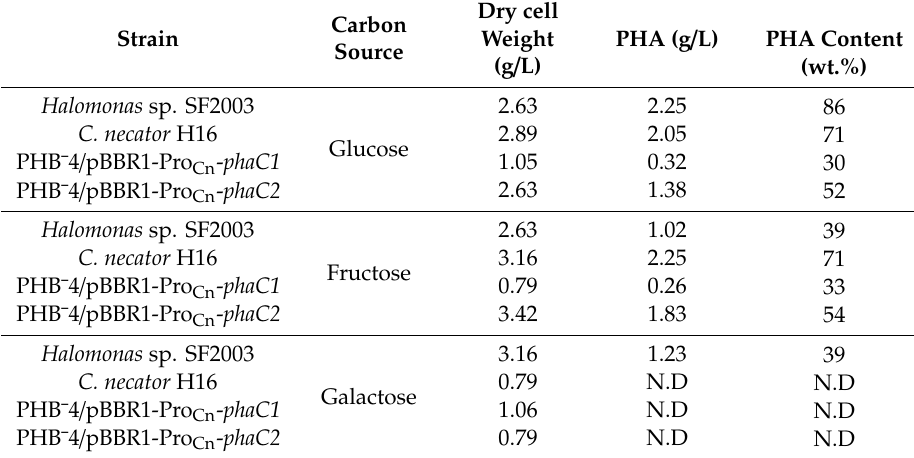
Table 7. Comparative PHA productions in shake flasks with glucose, fructose or galactose. Productions carbon